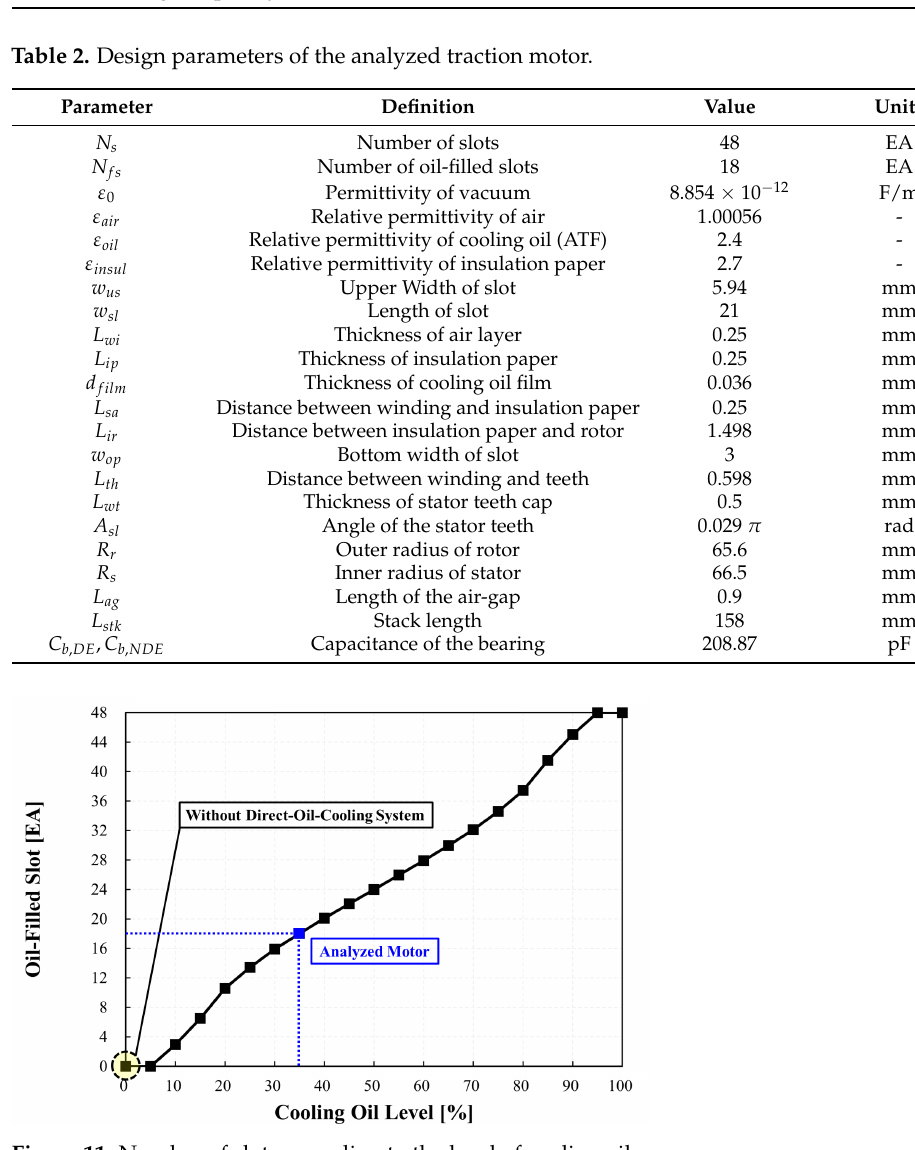
Figure 11. Number of slots according to the level of cooling